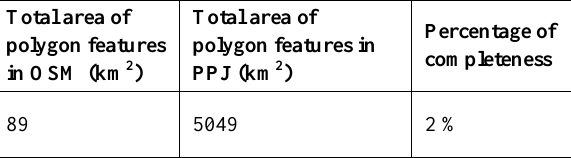
Table 6: The comparison of features completeness